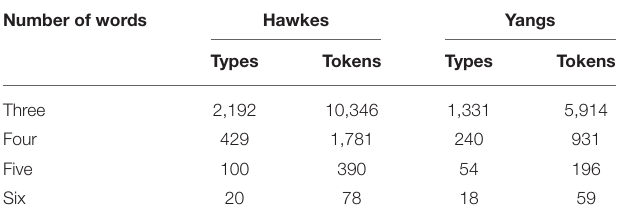
TABLE 3 | Statistical comparison of lexical